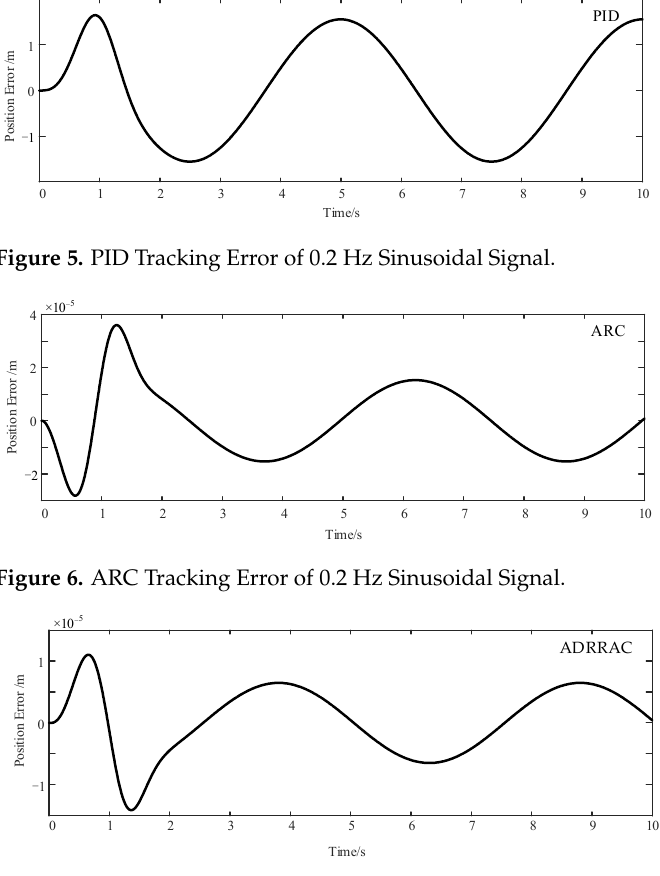
Figure 7. ADRRAC Tracking Error of 0.2 Hz Sinusoidal Signal.